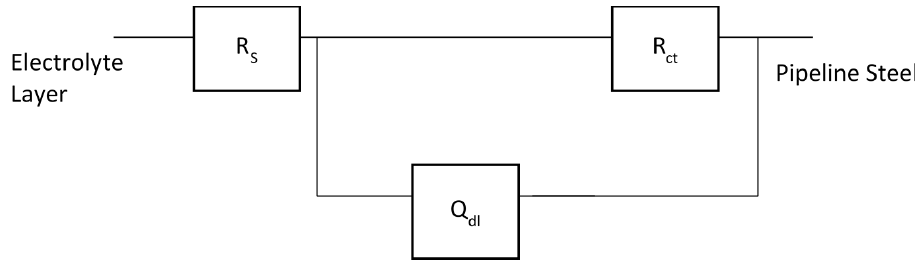
Figure 6. The electrochemical equivalent circuit used to fit EIS data for API-X120 steel in GTL process water at OCP with frequency. Table 6. Fitting values to EIS at different temperatures.